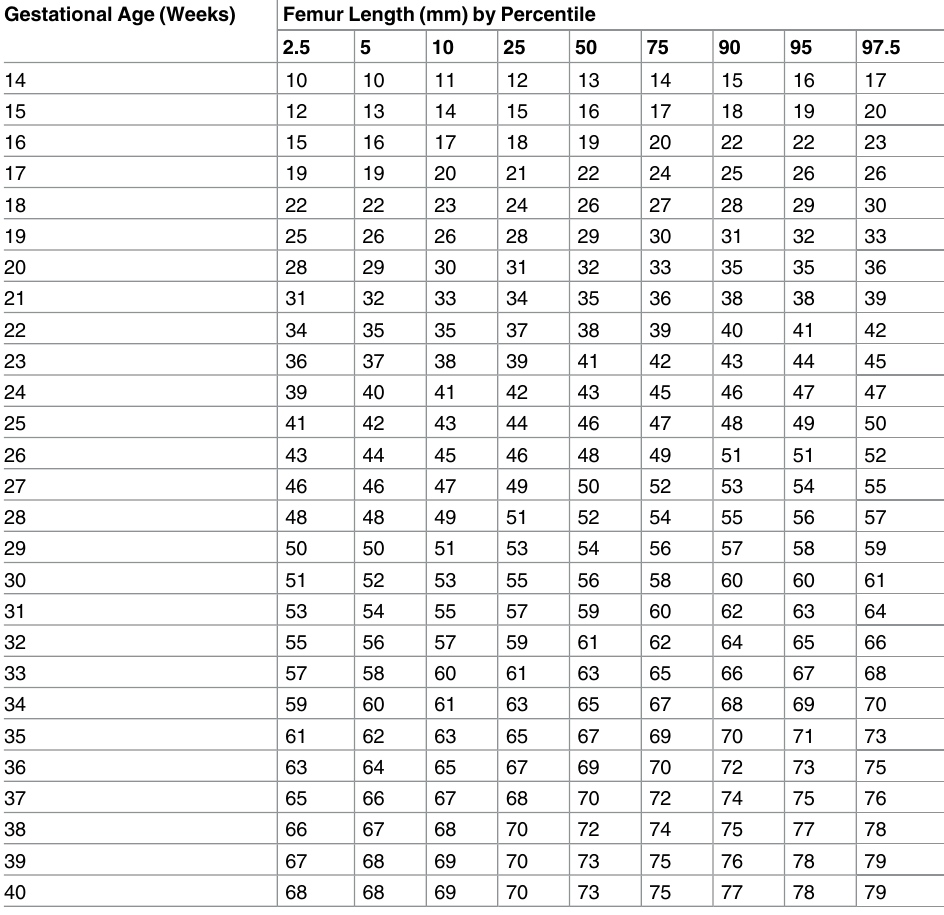
Table 9. Growth chart for fetal femur length. Gestational Age